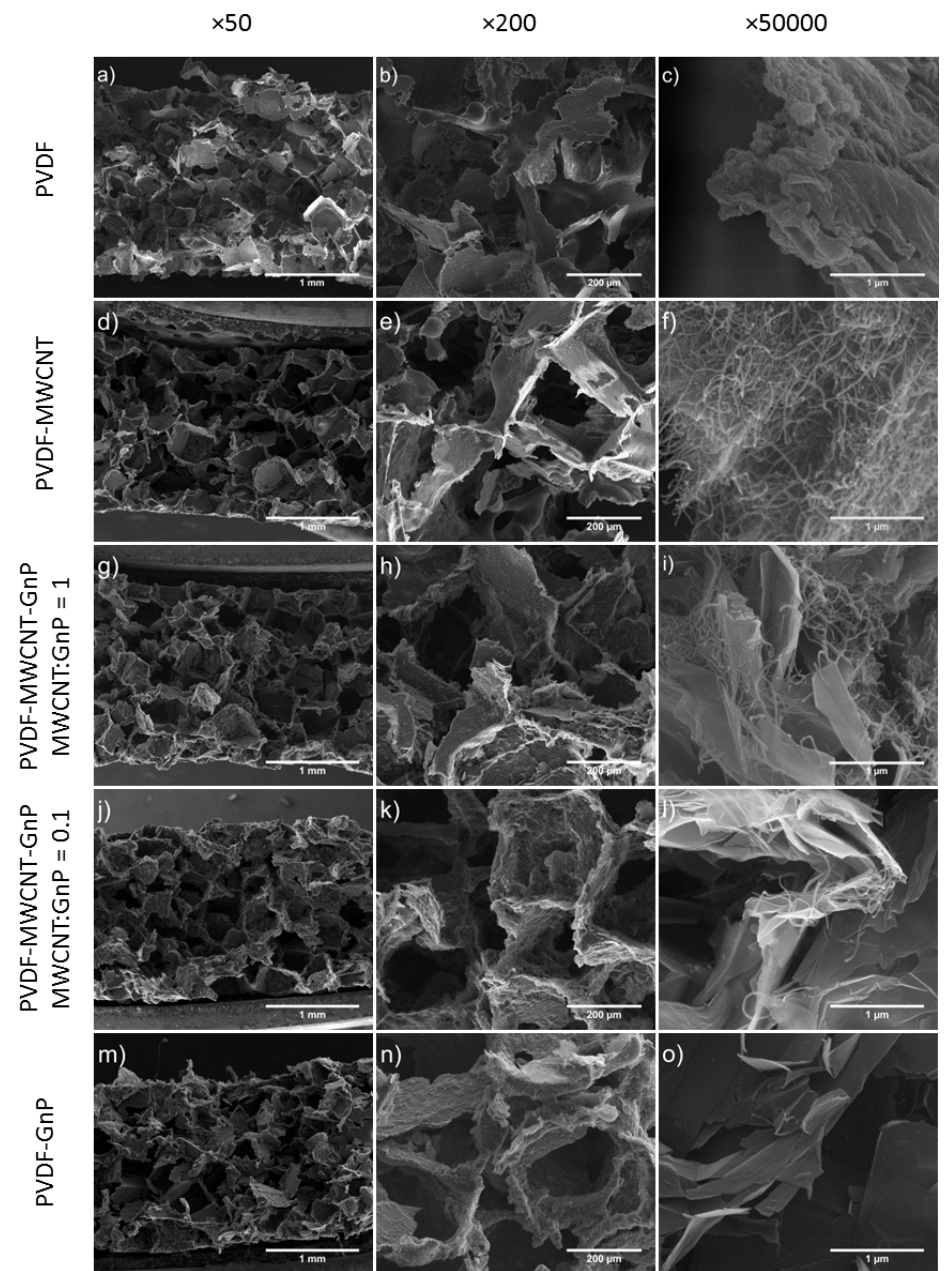
Figure 1. Scanning electron microscopy (SEM) micrographs that illustrate the foam and